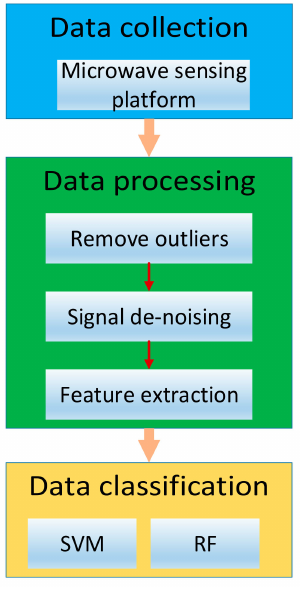
Figure 3. The experiment flow chart.